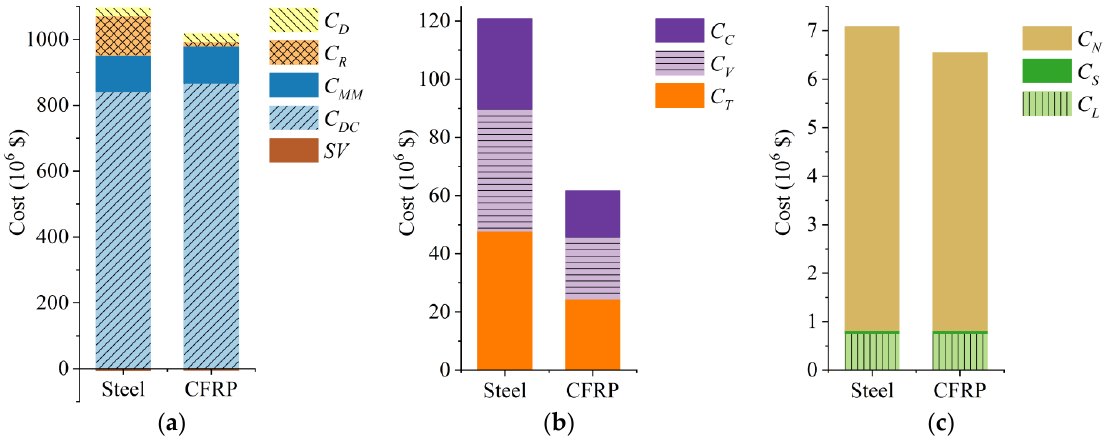
Figure 6. Category-by-category comparison of life-cycle costs (main span = 1200 m): ( a ) agency cost (AC); ( b ) user cost (UC); ( c ) vulnerability cost